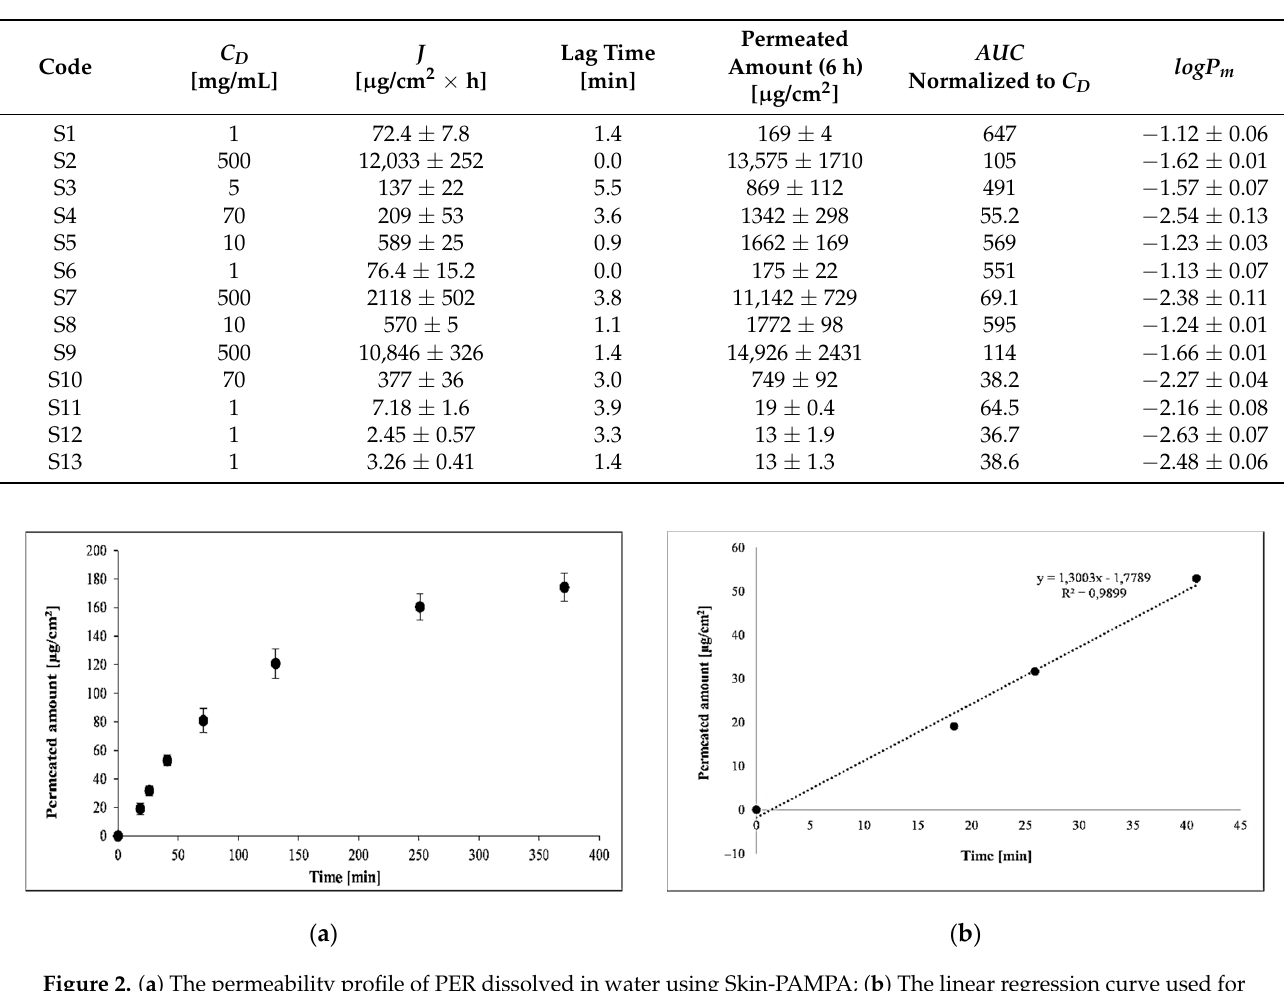
Table 3. Characteristic parameters of permeability of PER across Skin-PAMPA membrane for comparison when applied in different solvents.